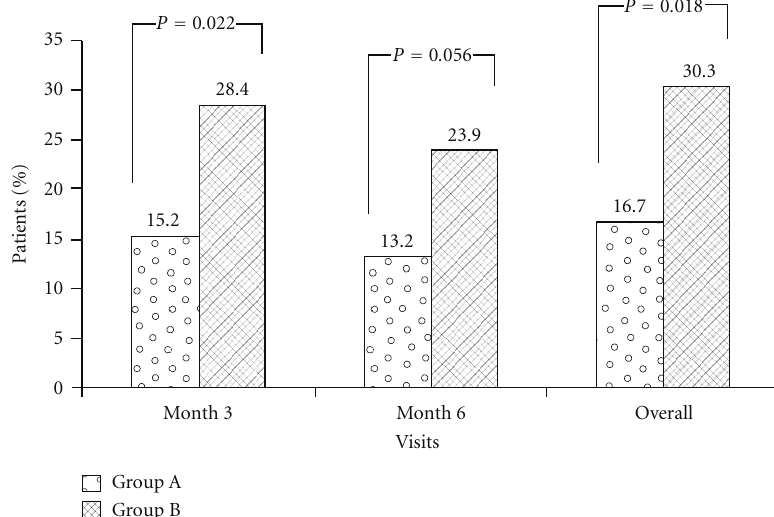
Figure 2: Incidence of new onset diabetes mellitus at month 3, 6, and overall (safety population Group A, n = 114; Group B, n = 109). NODM = patients treated for hyperglycemia for a period of 14 consecutive days, or had 2 h OGTT posttest value ≥ 200 mg/dL, or had at least two fasting glucose values ≥ 126 mg/dL, or had one single random value (fasting or nonfasting) ≥ mg/dL. Safety population, patients with diabetes mellitus active at start of study, was